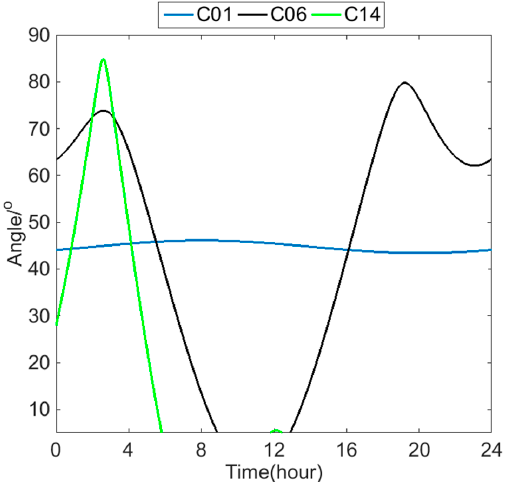
Figure 8. Daily elevation variety of satellites C01, C06 and C14 as seen from the receiver at Wuhan University.